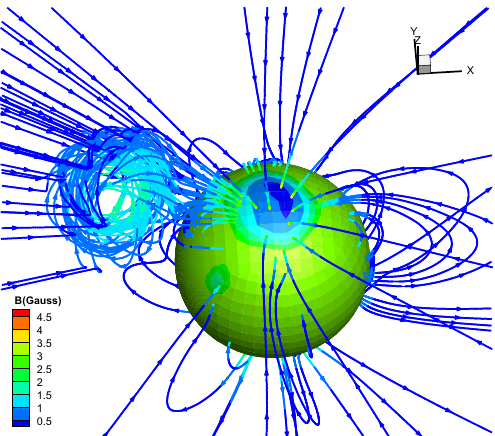
Fig. 2. Three dimensional view of the initial coronal magnetic fi eld. Field lines are shown in color to illustrate the magnetic fi eld strength. The color contours represent the radial magnetic fi eld strength on solar surface.